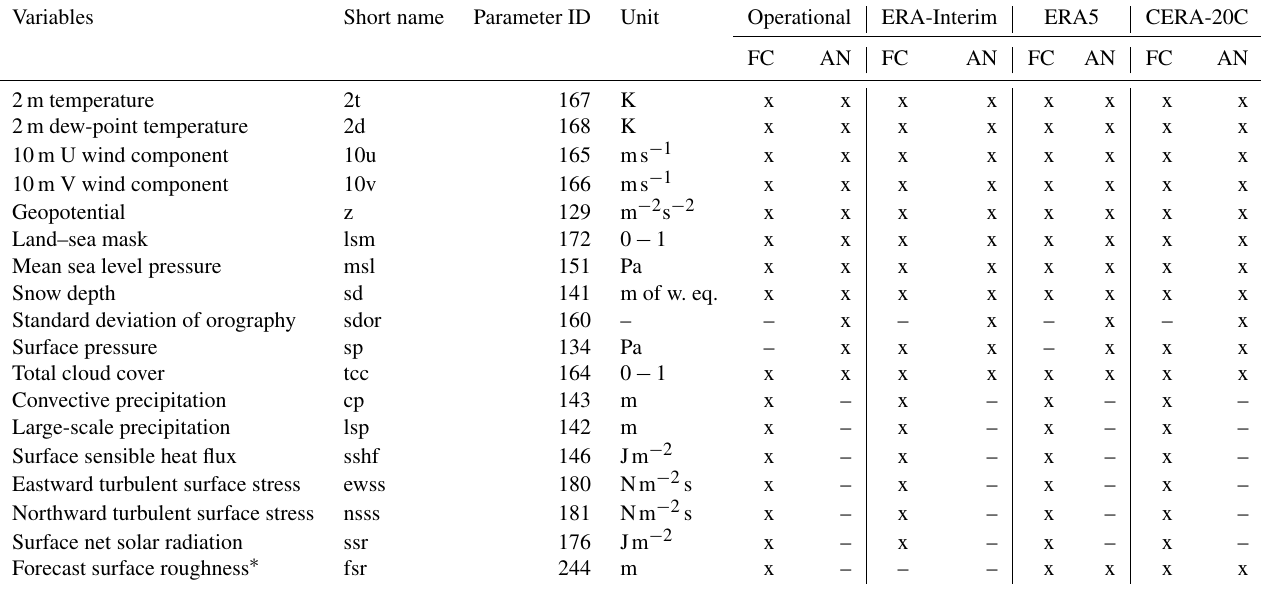
Table 18. List of surface level parameters FLEXPART requires to run and their availability from different data sets (ECMWF, 2019e,i). FC stands for “forecast” and AN for “analysis”. Special or future versions of FLEXPART or pre/post-processing software may require additional surface level fields which are not listed